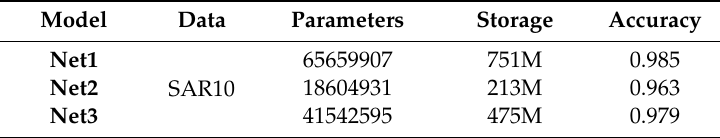
Table 7. Performance of feature fusion.